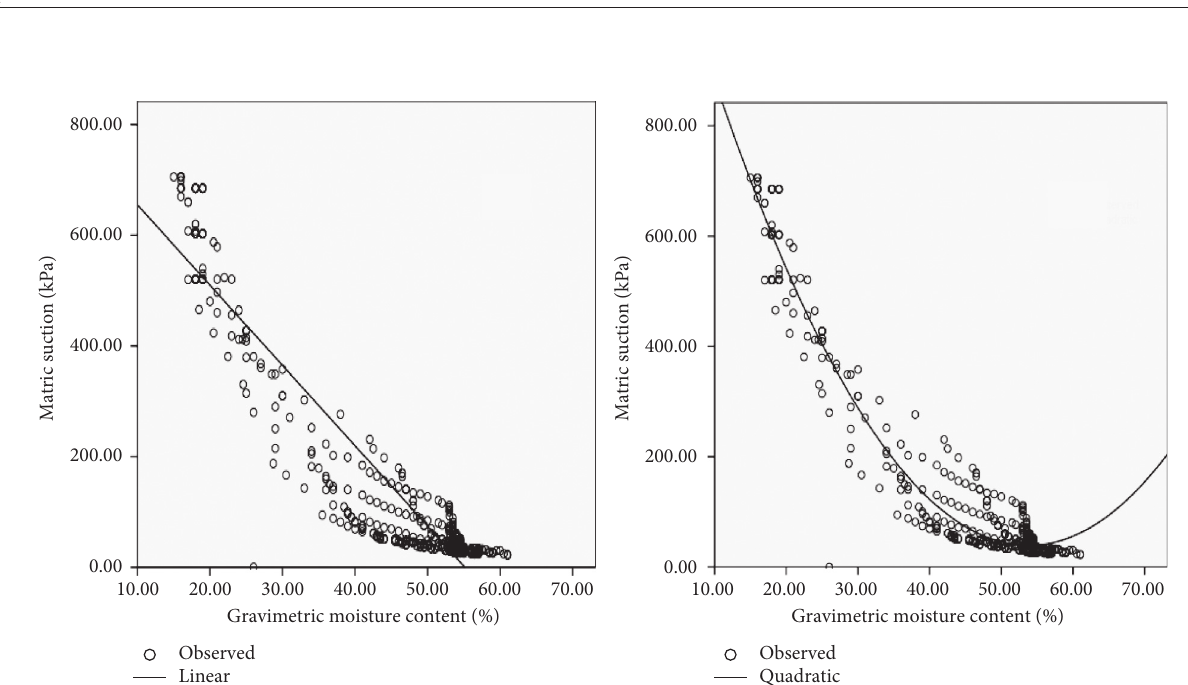
Figure 16: Line graphs produced in SPSS for linear and quadratic